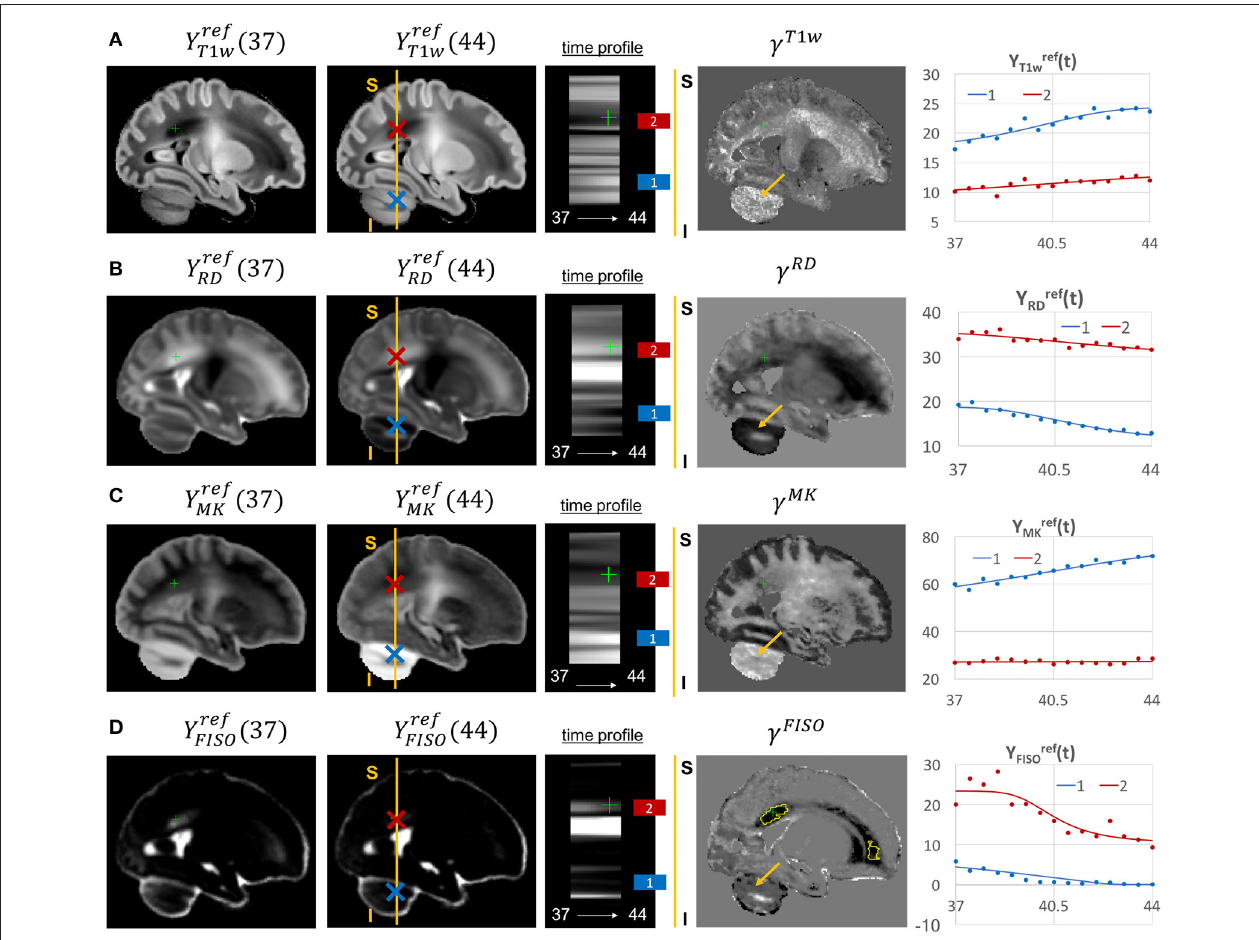
FIGURE 13 | Examples of the signal changes in time (in the reference space) in T1w (A) , RD (B) , MK (C) , and FISO (D) channels. First column: 37 week template. Second column: 44 week template. Third column: signal change in time. Fourth column: γ c maps. Fifth column: Signal change in time in age-specific templates Y (2) c , t and fitted Gompertz function Y ref c ( t ) computed over 3 × 3 × 3 voxel regions in two locations: cerebellum (blue) and periventricular crossroads (red). The regions highlighted with yellow contours have > 0.2 weeks growth peak offset in τ c